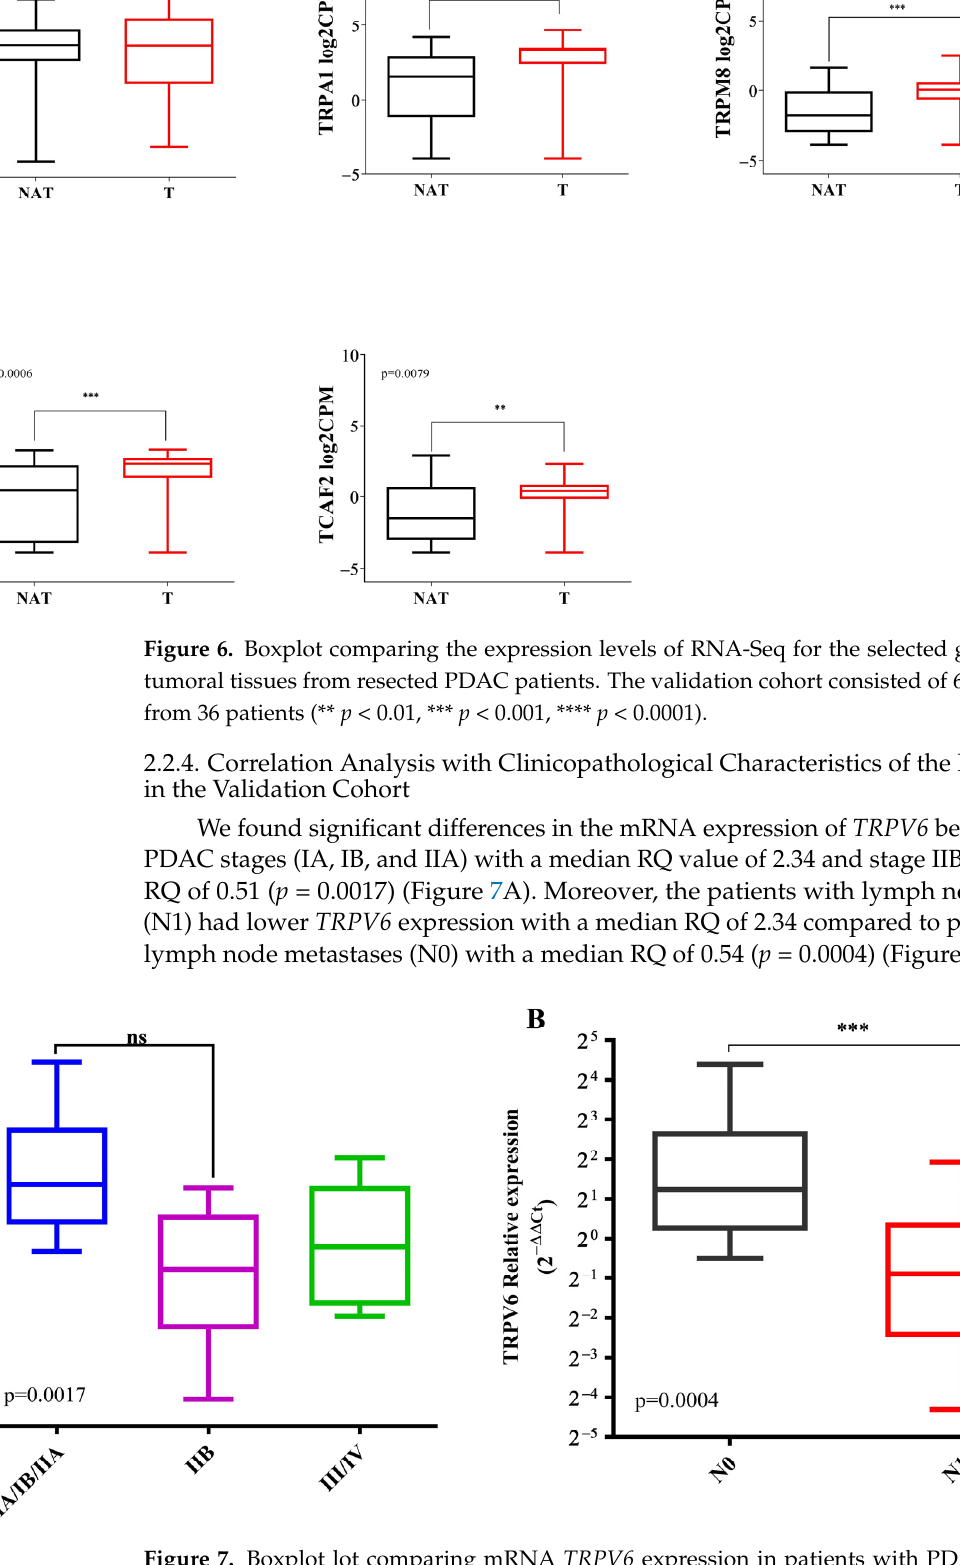
Figure 7. Boxplot lot comparing mRNA TRPV6 expression in patients with PDAC according to clinicopathological variables. ( A ). Tumoral stages, ( B ). lymph node status. *** p < 0.001, ns indicates no statistical significance.